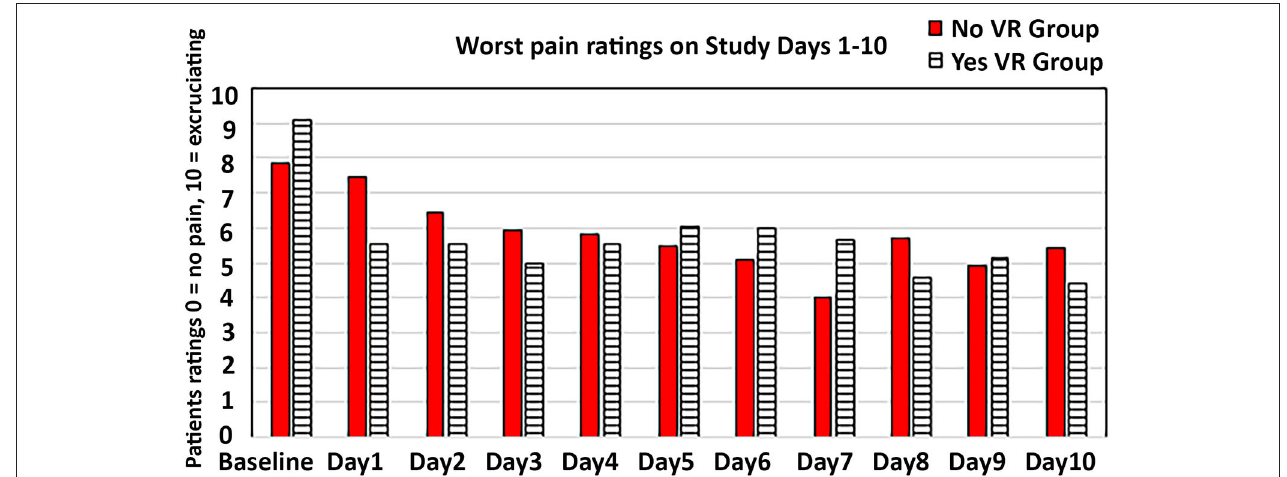
FIGURE 3 | A graph showing worst pain ratings during baseline, and Study Days 1–10, for the VR Group vs. the No VR Control Group. Note that all patients received No VR during wound care on the baseline day.